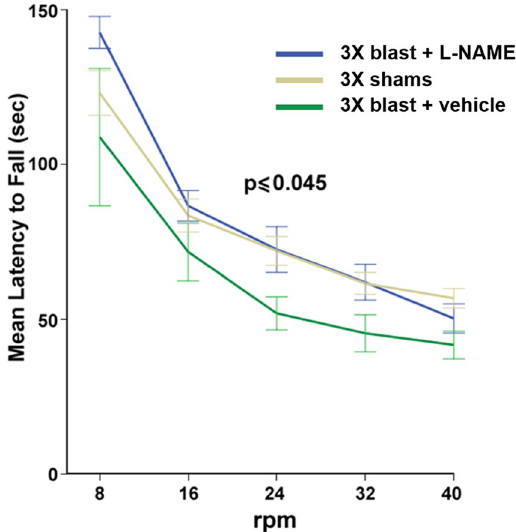
Figure 6. L-NAME improves sensorimotor impairment in mice exposed to repetitive blast. 3X blast and sham mice received L-NAME mice. In shams, L-NAME treatment had no significant effect on performance and were thus pooled (sham-vehicle n = 10, and sham L-NAME-treated n = 11). There was a significant overall difference ( p ≤ 0.045) between shams, blast vehicle-treated ( n = 14), and blast L-NAME-treated ( n = 14) mice. Mice exposed to repetitive mTBI one month prior exhibited impaired sensorimotor performance on a rotarod task ( p ≤ 0.05) compared to sham controls (pooled mice, mice administered L-NAME). Post-hoc analysis revealed blast L-NAME-treated mice performed significantly better than blast vehicle-treated mice ( p ≤ 0.02). Two-way ANOVA Helmert’s test. Values represent means ±